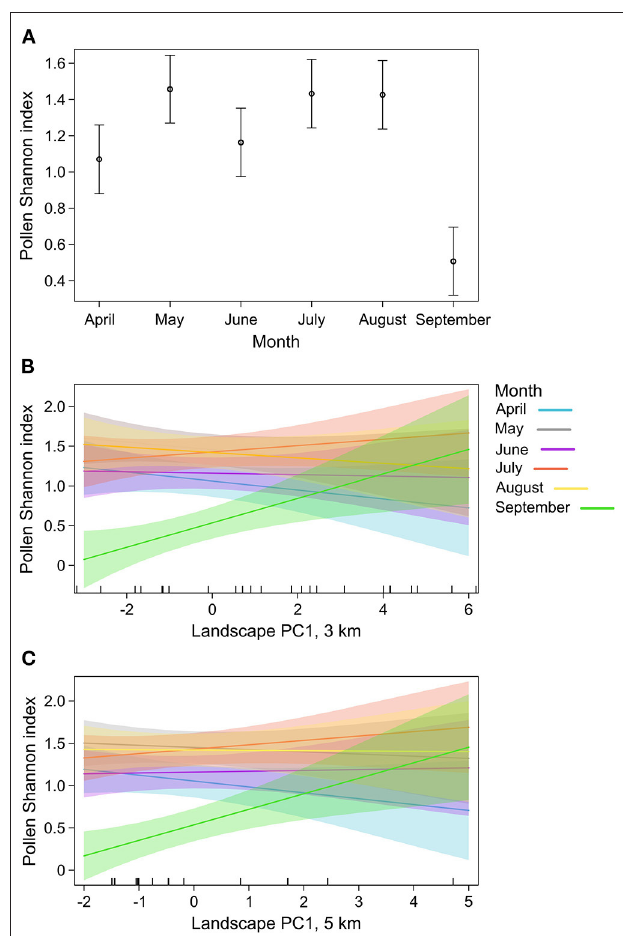
FIGURE 3 | Plot showing the effect on pollen Shannon index of (A) collection month, (B) the interaction between month and landscape PC1 at 3km radius buffer around the sampling locations, and (C) the interaction between month and landscape PC1 at 5km radius buffer around the sampling locations. Plots include model estimates (points and lines) and 95% confidence intervals (bars and shaded